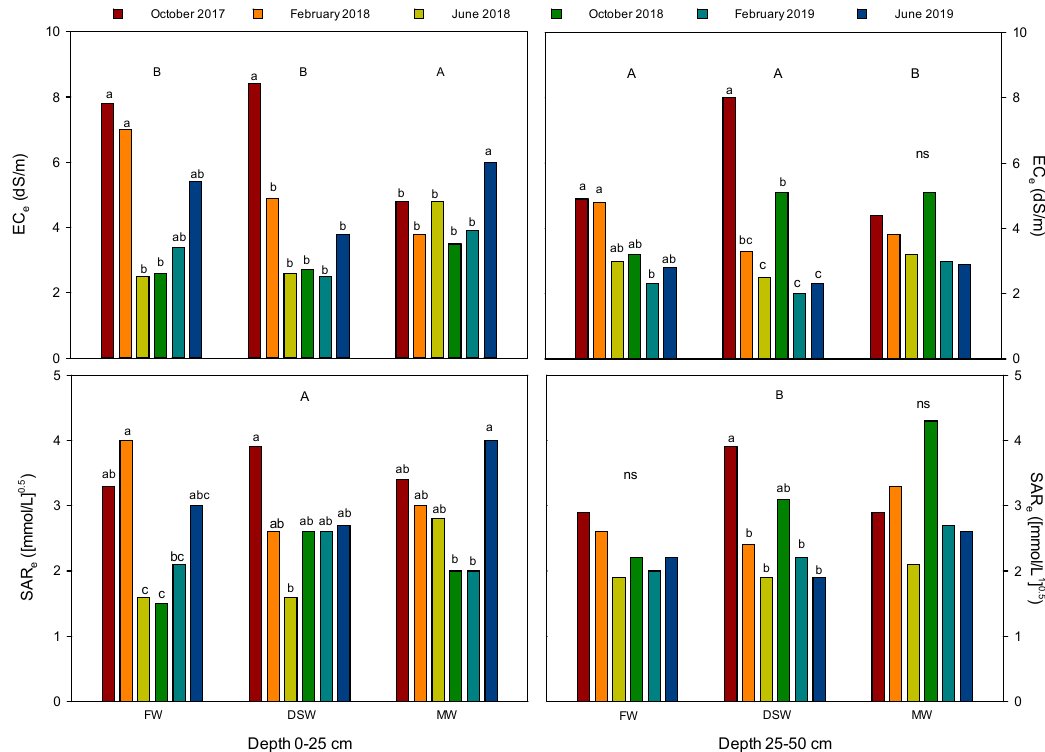
Figure 1. Electrical conductivity of the saturated paste extract (EC e , dS/m) and sodium adsorption ratio (SAR e ) in the three irrigation treatments (fresh water, FW; desalinized sea water, DSW; and mix water, MW) from October 2017 to June 2019 for 0–25 cm and 25–50 cm depths. Values represent the mean for each sampling period (N = 3 for each sampling). Similar small letters in each bar indicate no significant differences among samplings; no small letters means no significant differences; and different capital letters in each treatment for surface and depth samplings indicate significant differences between depths, in both cases according to Tukey’s HSD test (P ≤ 0.05).